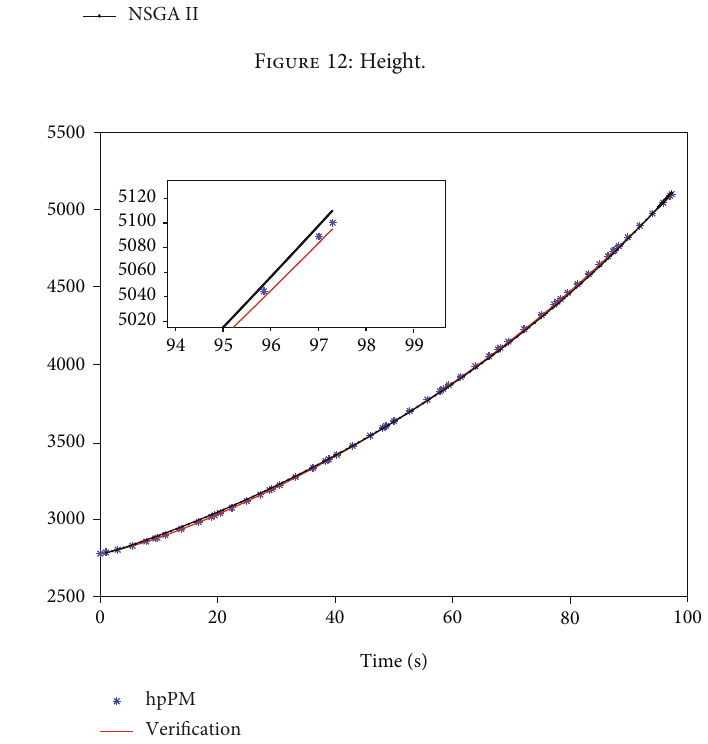
Figure 12: Height.